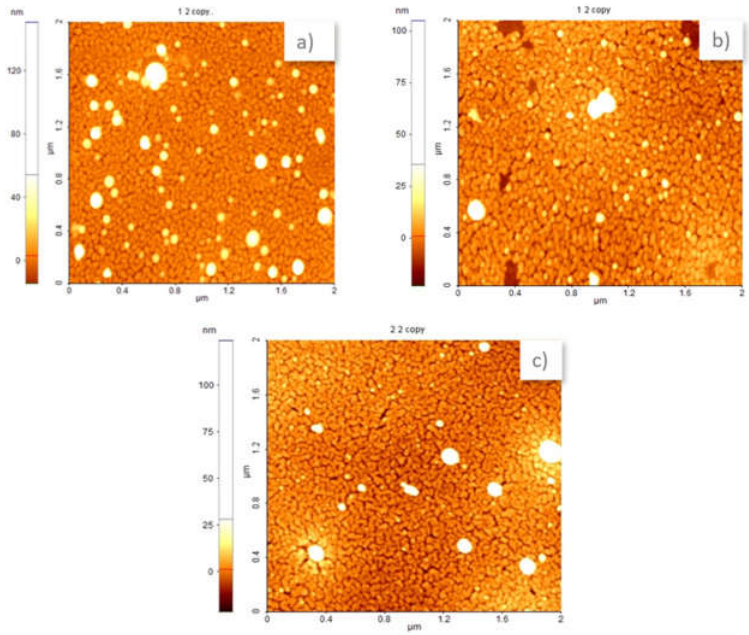
Figure 5. AFM images of the sensor surface after deposition of avidin or biotin/avidin on top of the Au layer: ( a ) avidin deposited on top of Au obtained in 1 Torr Ar using 10,000 p; ( b ) avidin deposited on top of Au obtained in 4 Torr Ar using 30,000 p; ( c ) biotin deposited on top of the avidin in ( c ).